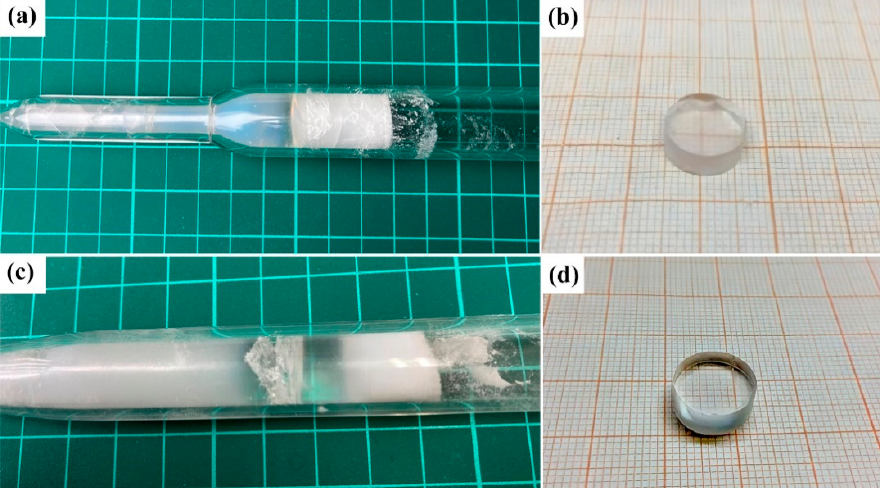
Figure 1. Photographs of ( a ) CKLC and ( c ) CKCC crystal in an ampoule, photographs of ( b ) CKLC and ( d ) CKCC polished crystal